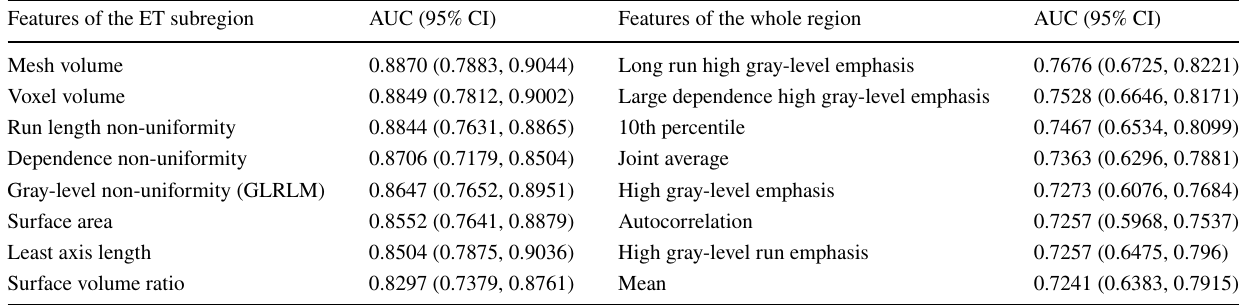
Table 3 Comparative results of AUC of the eight top-ranked features from the T2-based ET subregion and whole tumor for glioma grade Features of the ET subregion